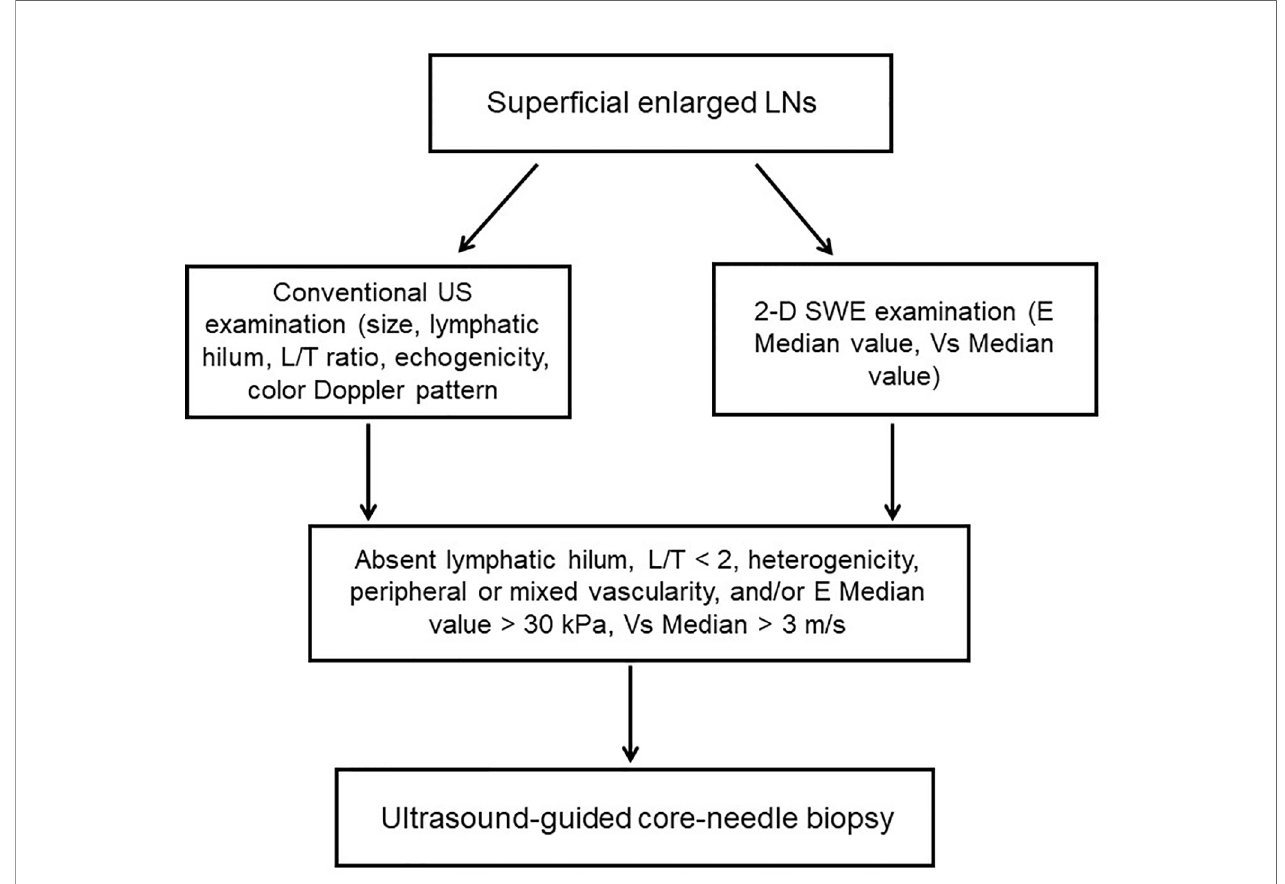
FIGURE 1 | Flowchart of the study. LNs, lymphatic nodes; L/T ratio, longitudinal axis/transverse axis ratio.